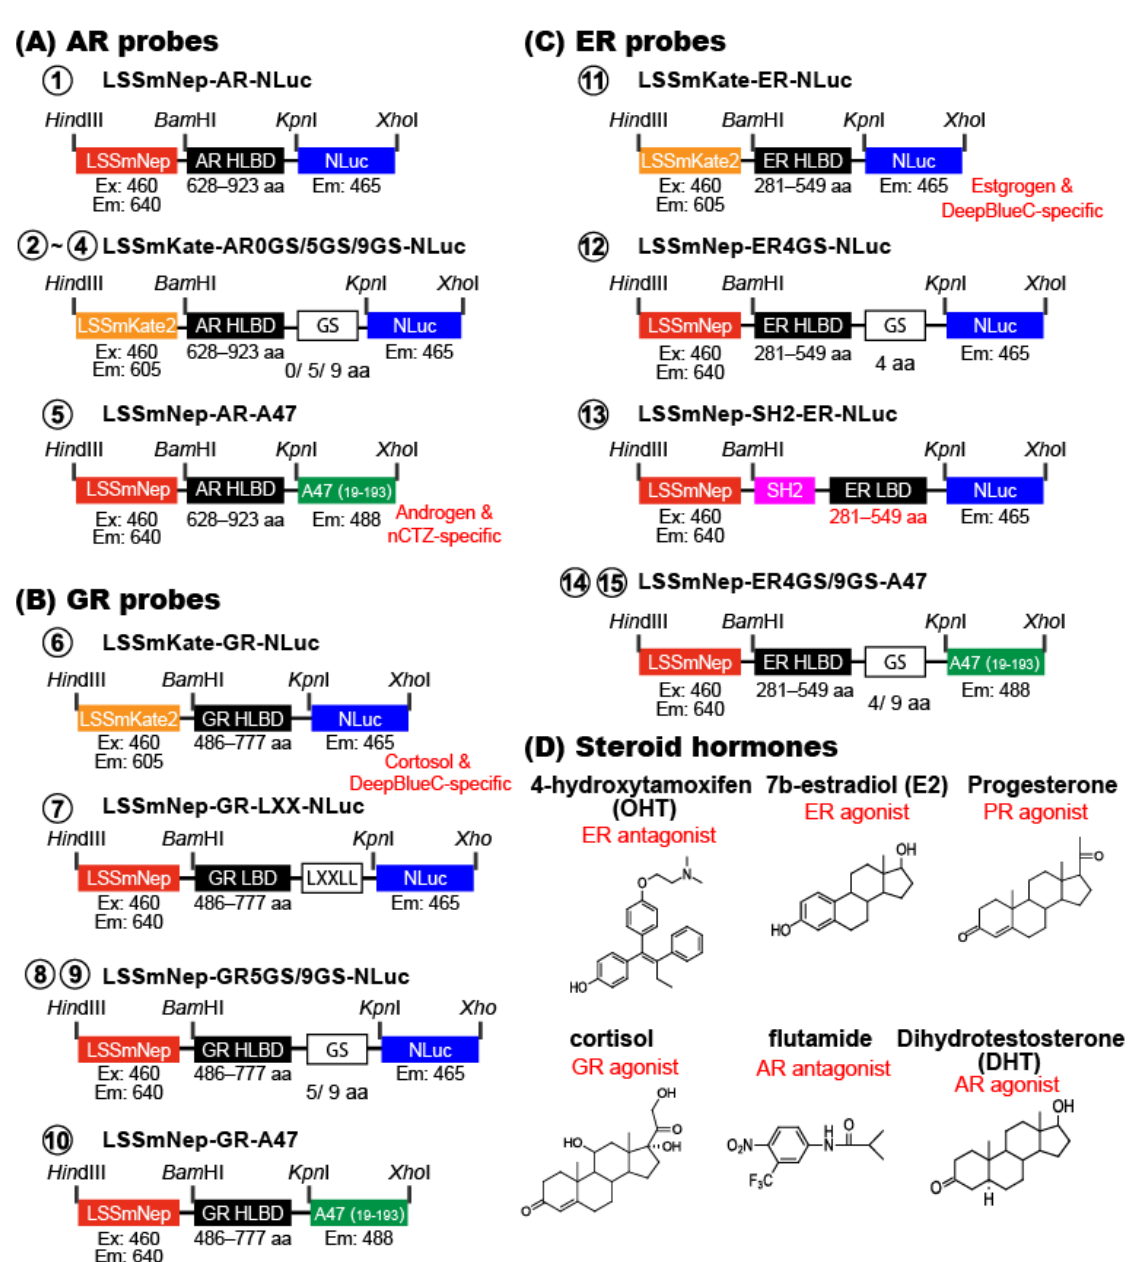
Figure 4. cDNA constructs encoding various BRET probes for imaging steroid hormones. ( A ) A schematic diagram of BRET probes sandwiching AR HLBD. ( B ) A schematic diagram of BRET probes sandwiching GR HLBD. ( C ) A schematic diagram of BRET probes sandwiching ER HLBD. ( D ) The chemical structures of steroid hormones and their antagonists.